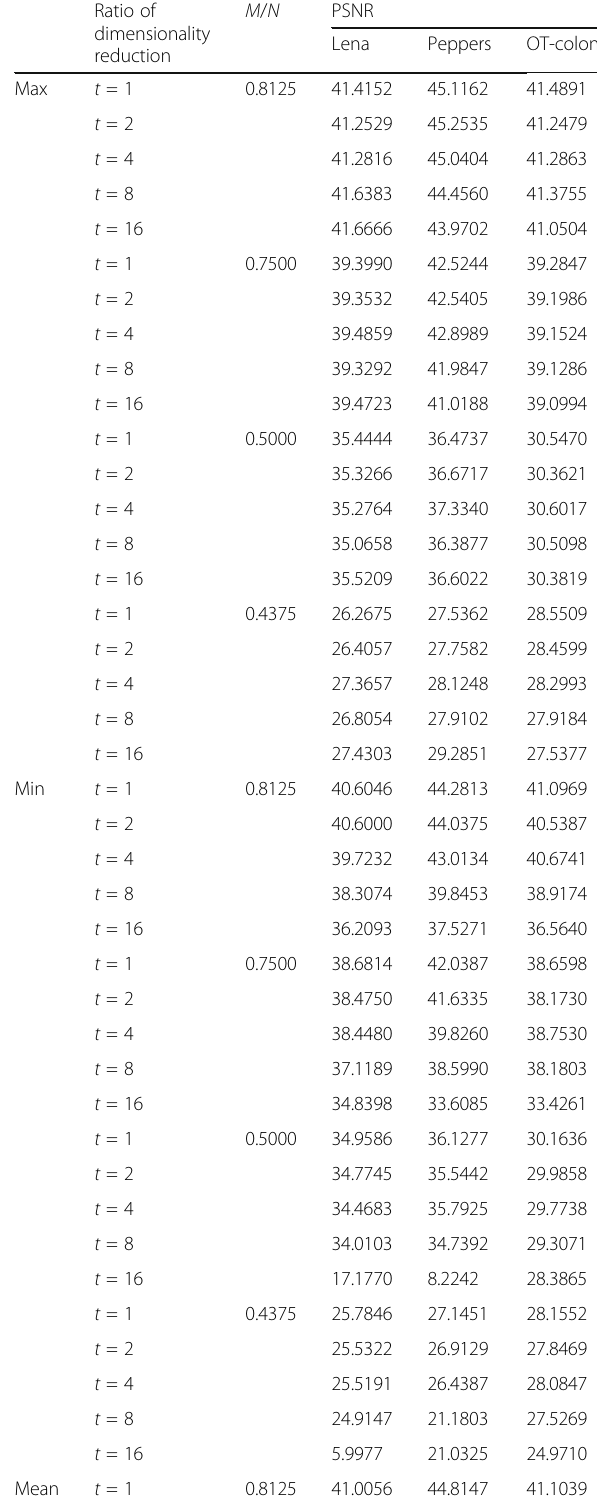
Table 3 Comparison of the PSNR of reconstructions with different dimensions of Gaussian measurement matrices ( ℓ 0 -minimization with ρ = 0.8)